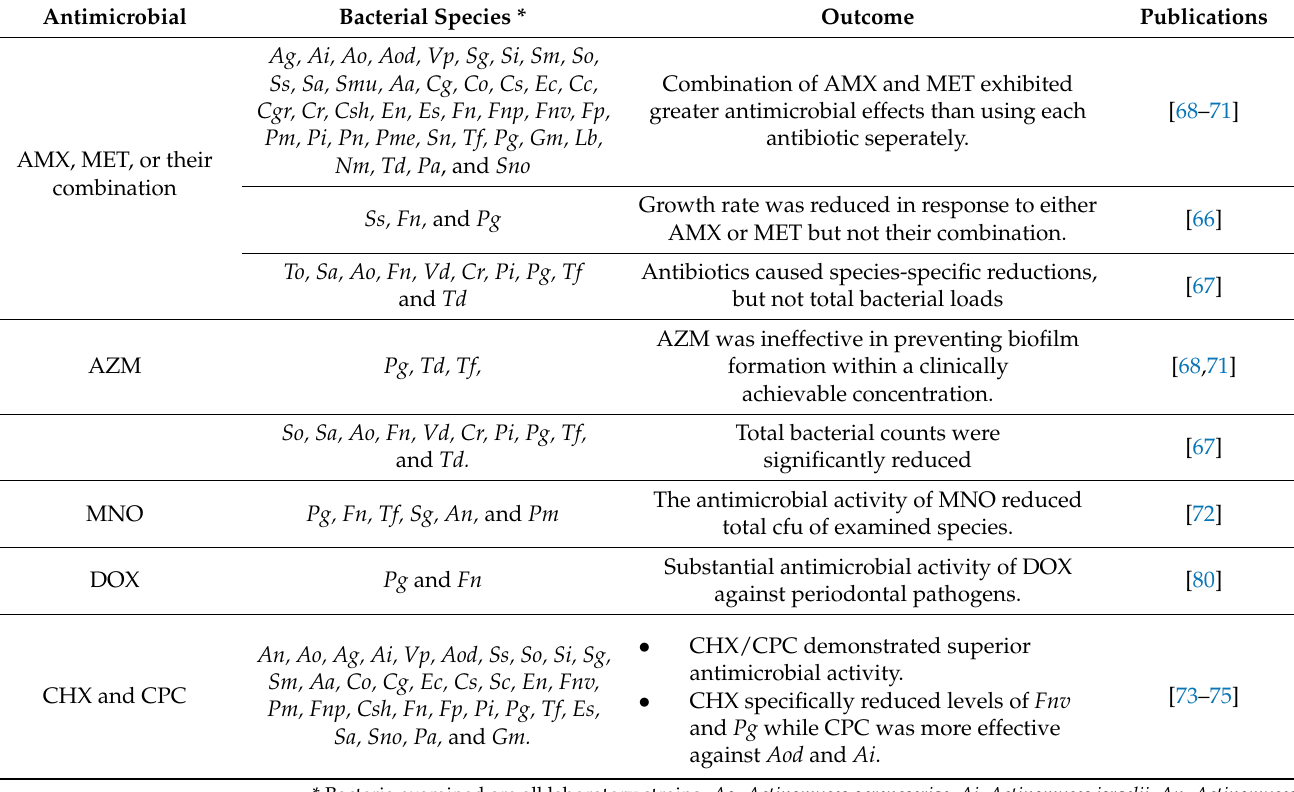
Table 1. Summary of in vitro studies on efficacy of commonly used antimicrobial agents against periodontitis-associated